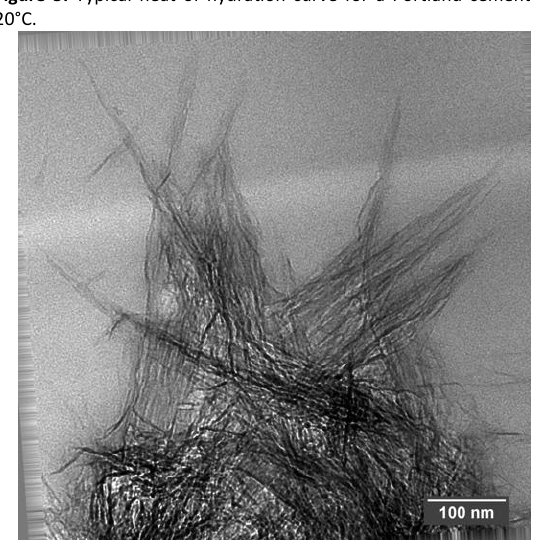
Figure 6. TEM micrograph of C ‐ S ‐ H, showing sheet like structure within “needle” like growth. C ‐ S ‐ H is now known to be nanocrystalline (rather